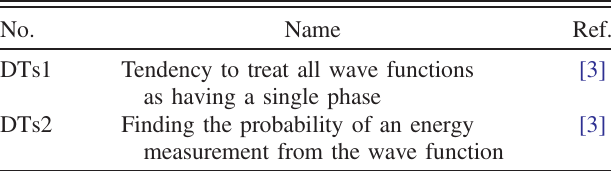
TABLE VII. Difficulties that exhibit both displacement and transition errors in problems which require frame shifting. These difficulties are labeled “ DT ” for displacement and transition errors and s because their problems require shifting. The ordering of the difficulties in the table is for labeling purposes only and does not represent a hierarchy.